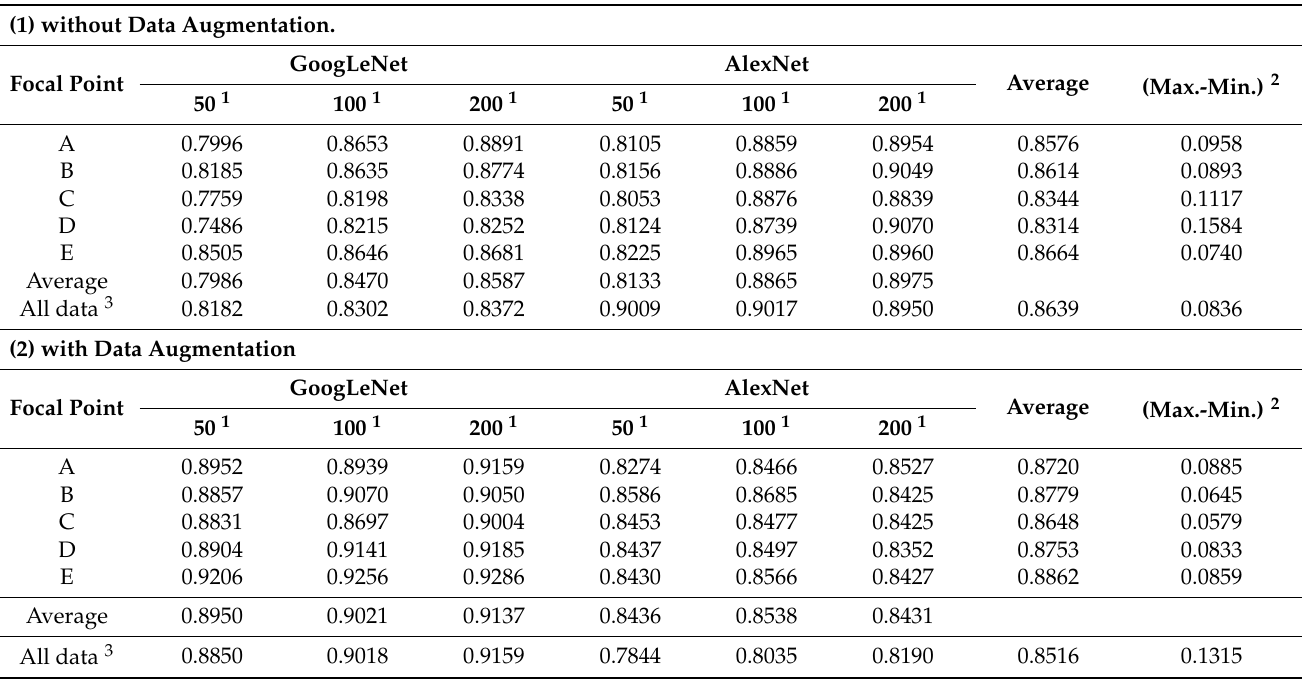
Table 2. Tree species classification accuracy in terms of Matthews correlation coefficient (MCC), calculated from the sum of 10 simulation results. Numbers 1 and 2 indicate without and with data augmentation,